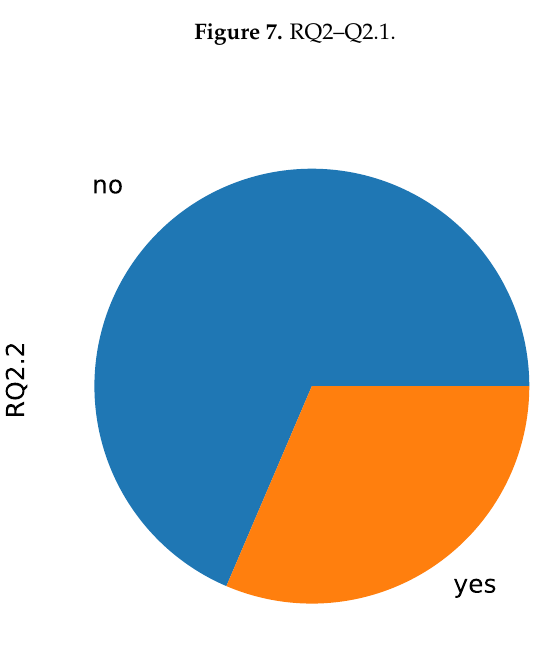
Figure 7. RQ2–Q2.1.